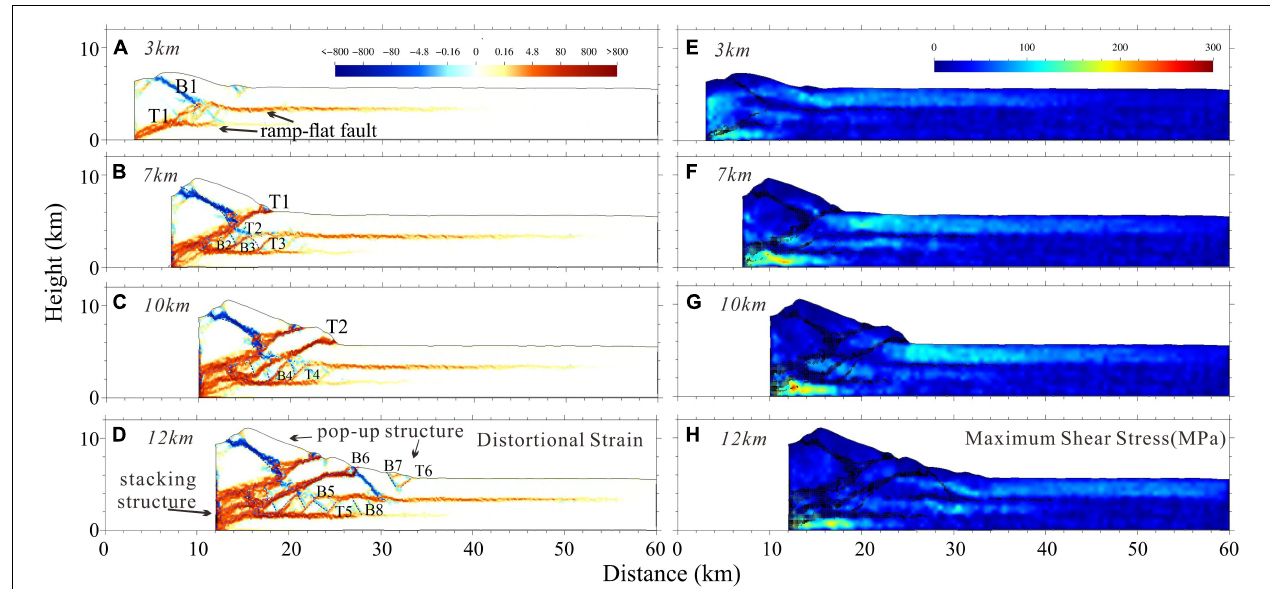
FIGURE 5 | Final distortional strain field (left) and final maximum shear stress field (right) for simulation with two detachments at shortening distances of (A,E) 3 km, (B,F) 7 km, (C,G) 10 km, and (D,H) 12 km. Shear strain magnitude is shown by color intensity. Red indicates top-to-the-right sense of shear; blue indicates top-to-the-left sense of shear. Stress intensity scales with color. T1–T6 and B1–B8 denote fore-thrusts and back-thrusts, respectively, in the order of their